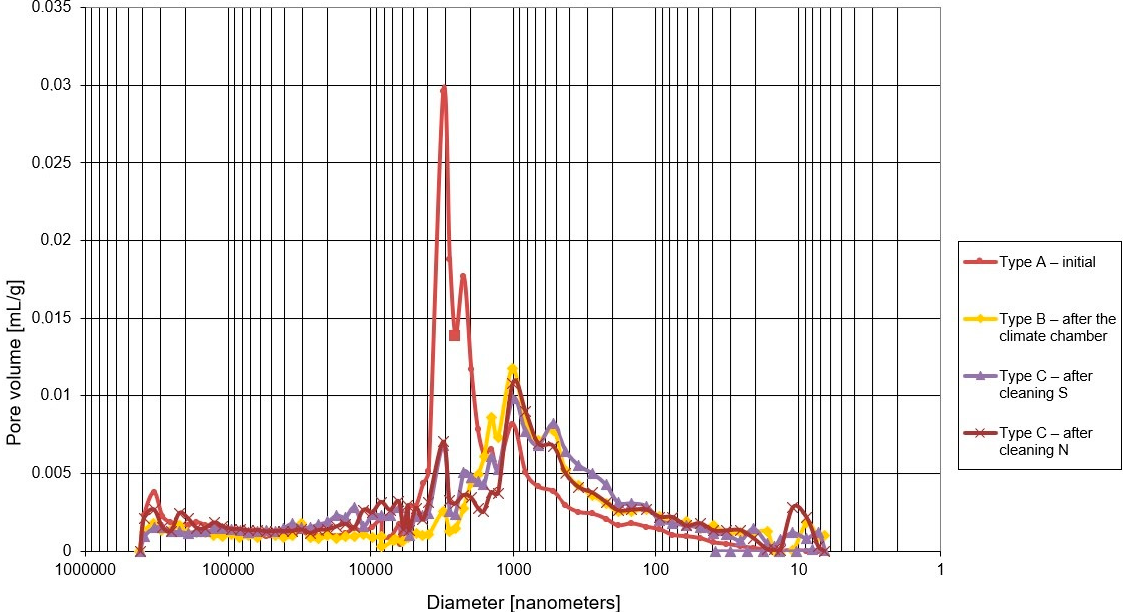
Figure 8. Differential curves of pore distribution for mineral-based plaster.